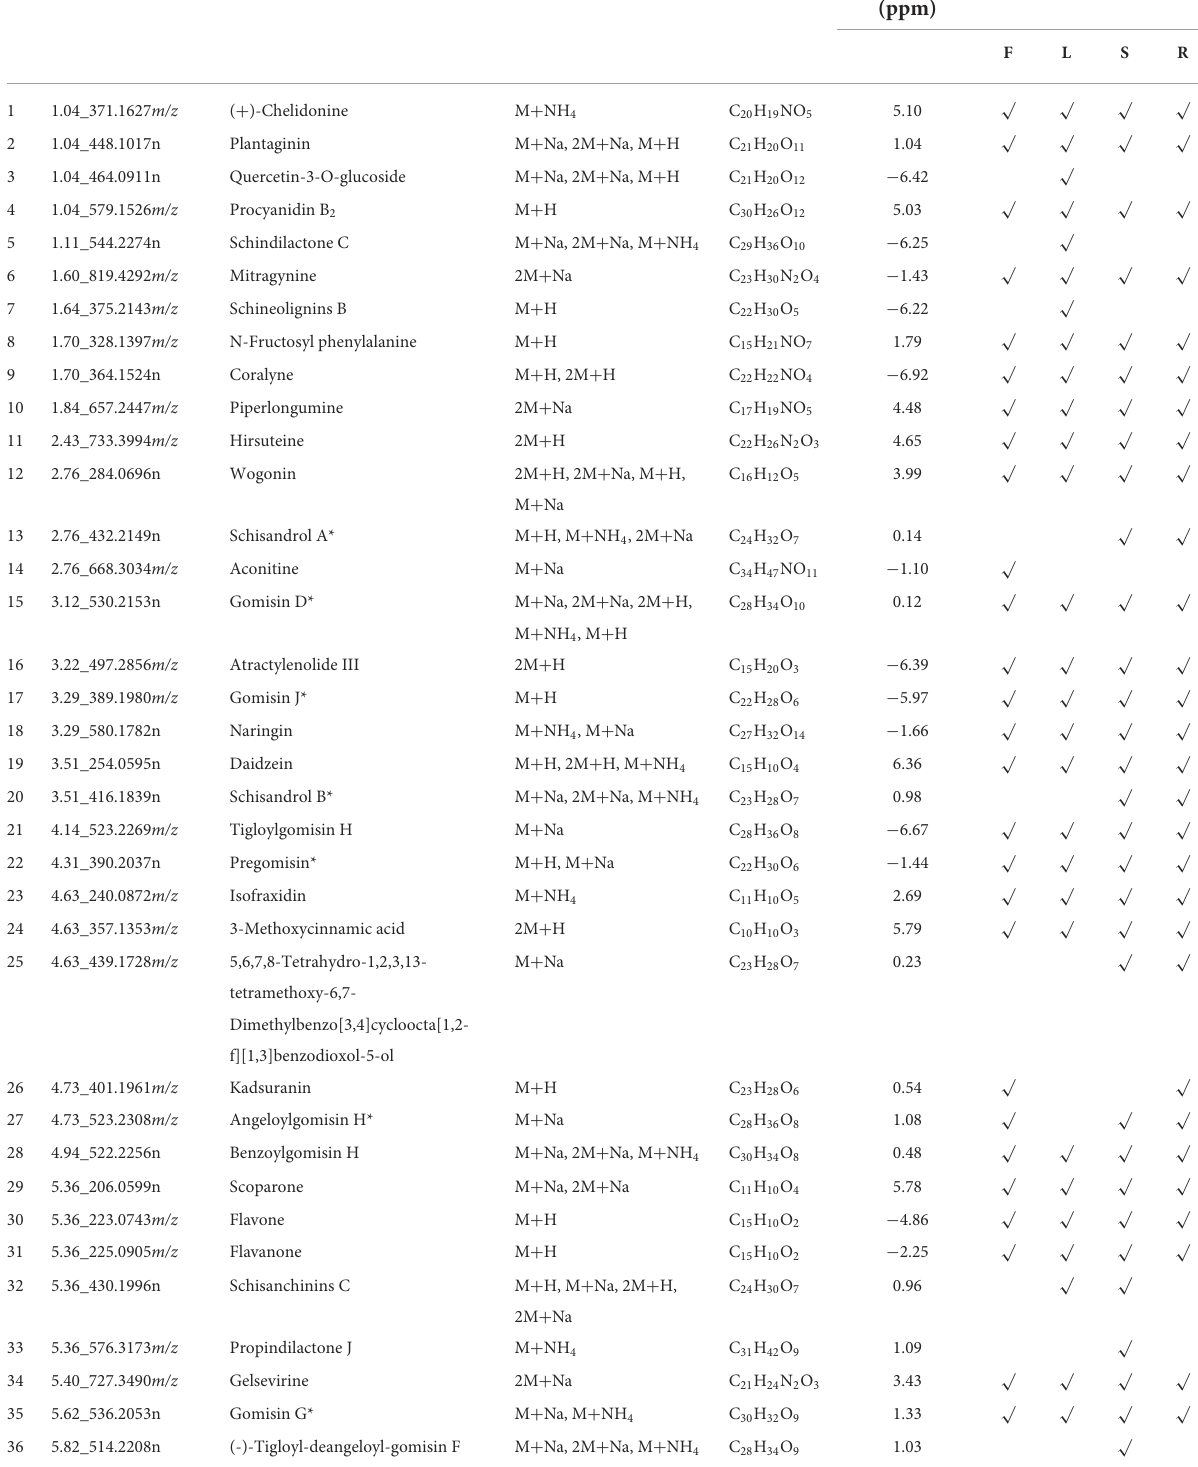
TABLE 2 A total of 76 metabolites identified in positive ion